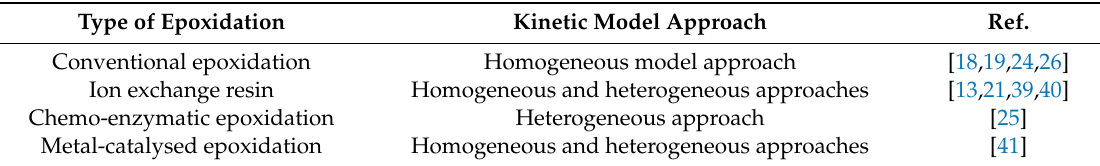
Table 10. Kinetics of